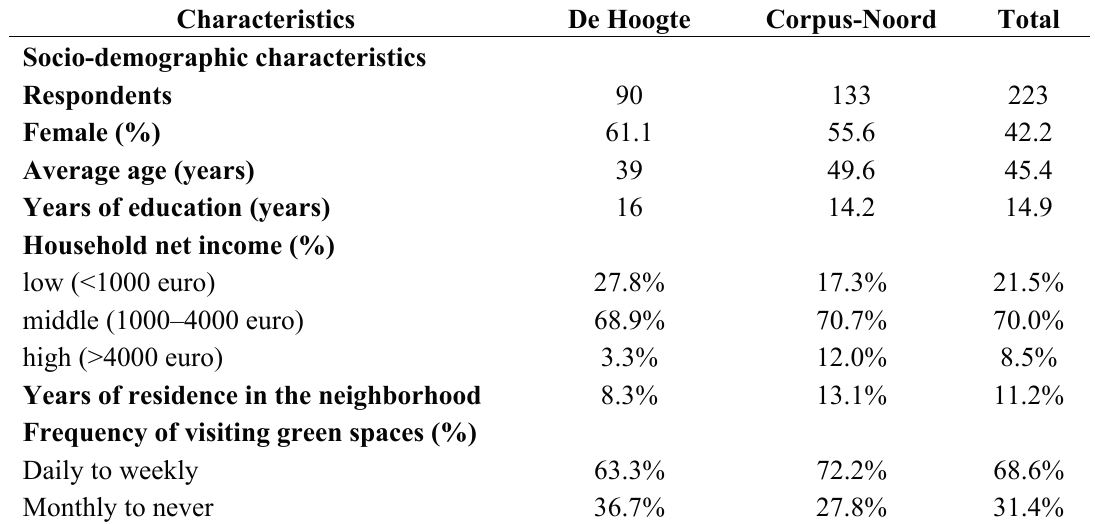
Table 3. Self-reported socio-demographic statistics of the participants from the two neighborhoods. Characteristics De